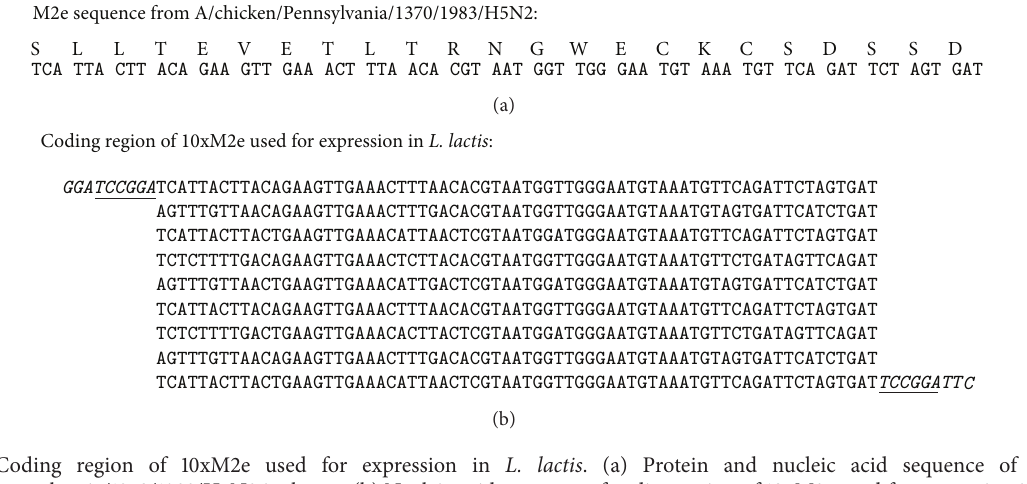
Figure 1: Coding region of 10xM2e used for expression in L. lactis . (a) Protein and nucleic acid sequence of M2e from A/chicken/Pennsylvania/1370/1983/H5N2 is shown. (b) Nucleic acid sequence of coding region of 10xM2e used for expression in L. lactis is shown. The bases in italics were added to the ends of the coding region for 10xM2e. BspE1 sites (underlined) were used to clone the sequence in-frame into the unique BspE1 site in